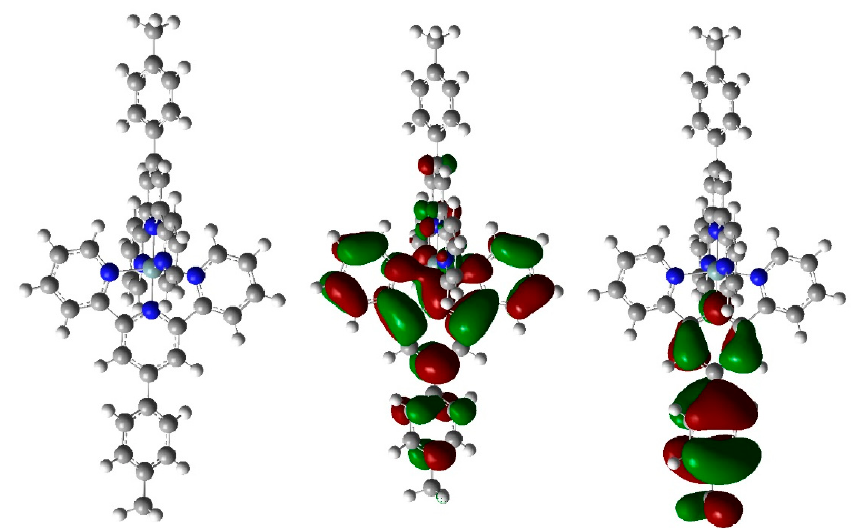
Figure 5. Optimized structure ( left ), HOMO ( center ), and LUMO ( right ) of [Si(ttpy) 2 ] 4+ , S = 0, solvated with CH 3 CN. Table 2. The self-consistent field calculation (SCF) reported in Hartrees for the geometry-optimized ions [Si(bpy) 3 ] n+ and [Si(ttpy) 2 ] n+ with charge (n) and total spin (S). Species